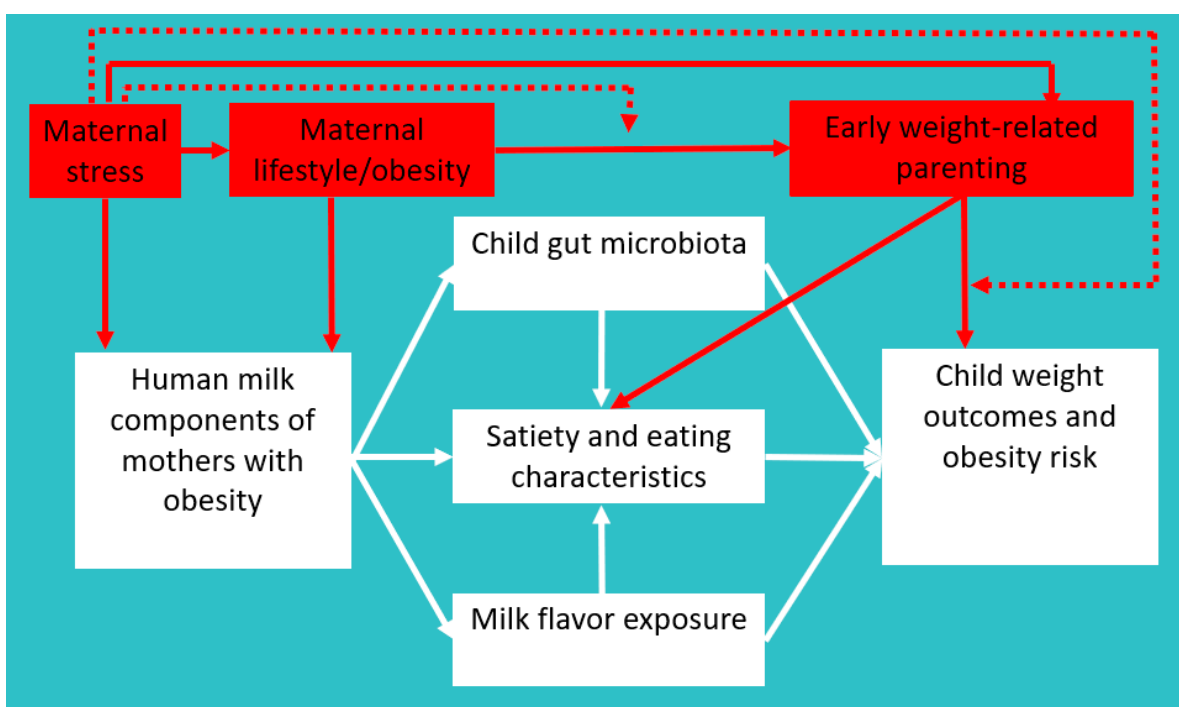
Figure 1. A theoretical model explaining the link between human milk composition among mothers with obesity and child weight outcomes. The red parts indicate exciting future research avenues; dotted lines reflect moderation. The exemplar intervention strategies are not meant to be exhaustive.